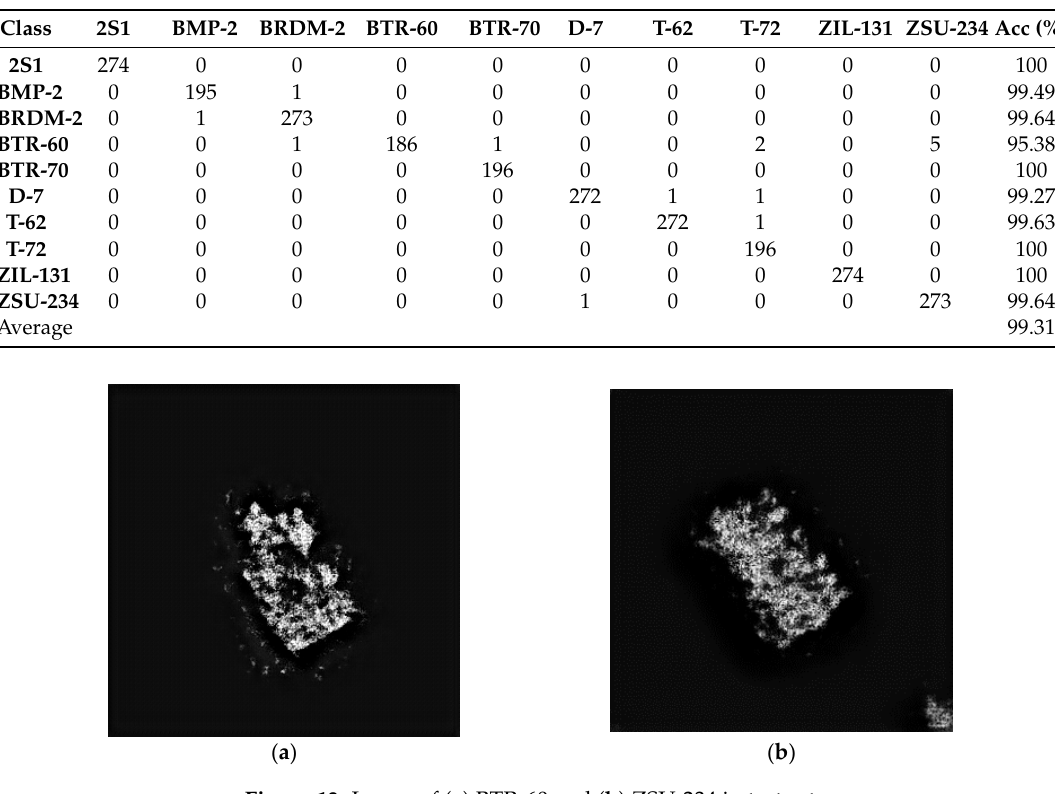
Table 3. Description of training and test sets under